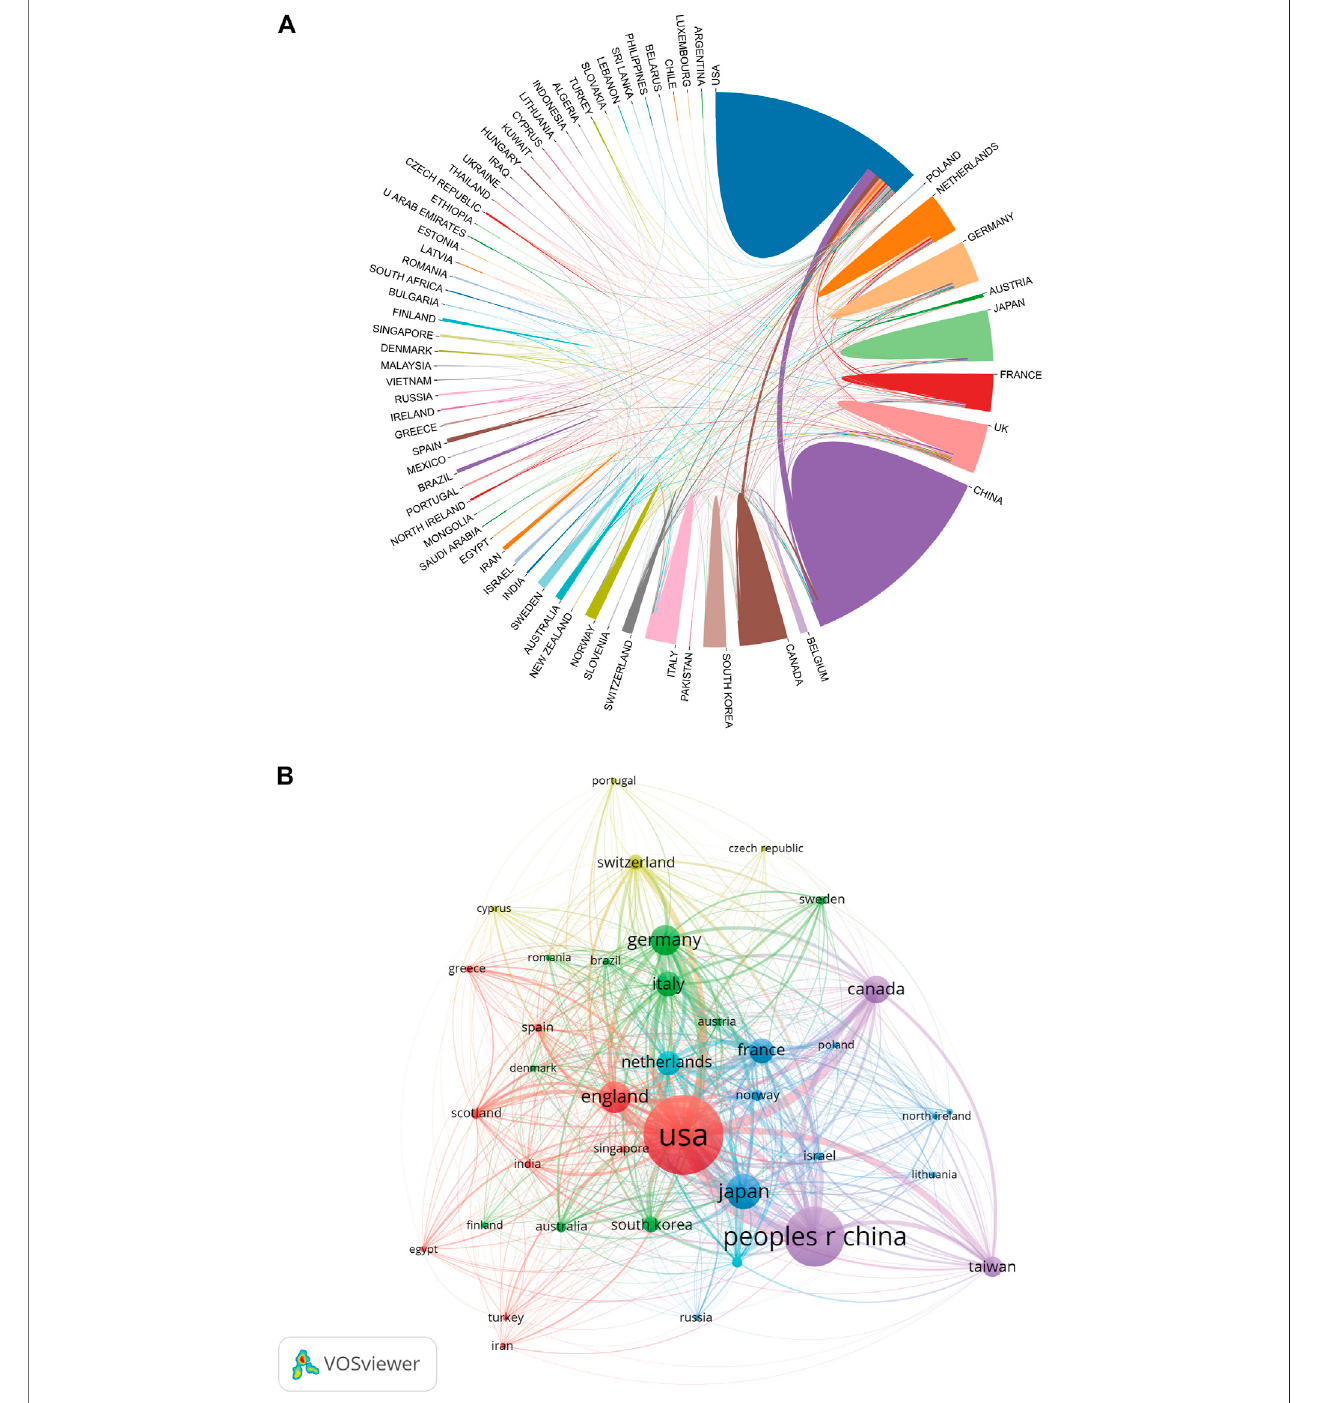
FIGURE 4 | (A) Distribution and international cooperation of countries/regions that are involved in ultrasound microbubble research. The thickness of the line re fl ects the frequency of the cooperation. The thicker the line, the stronger the cooperation. (B) Citation map of countries/regions on ultrasound microbubble research generated by the VOS viewer. Each node represents a country/region, and node size indicates the number of publications. The connection between the nodes represents a citation relationship, and the thickness of the lines indicates citation strength (weights on the TLS).